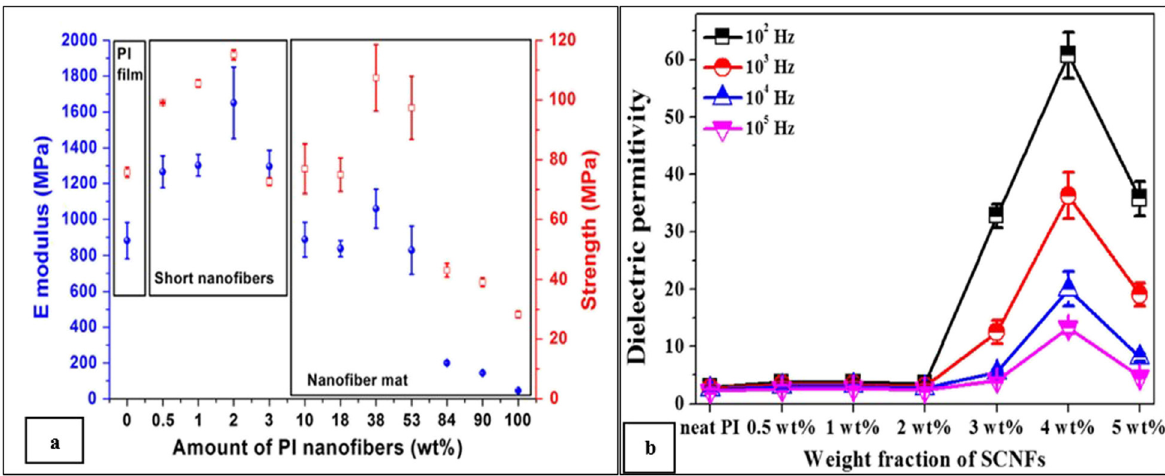
Figure 8: ( a ) Mechanical reinforcing potential of short nano fi ber [ 48 ] and ( b ) improvement in dielectric properties at optimum short nano fi ber concentration [ 52 ] ; Reproduced with permission from Elsevier